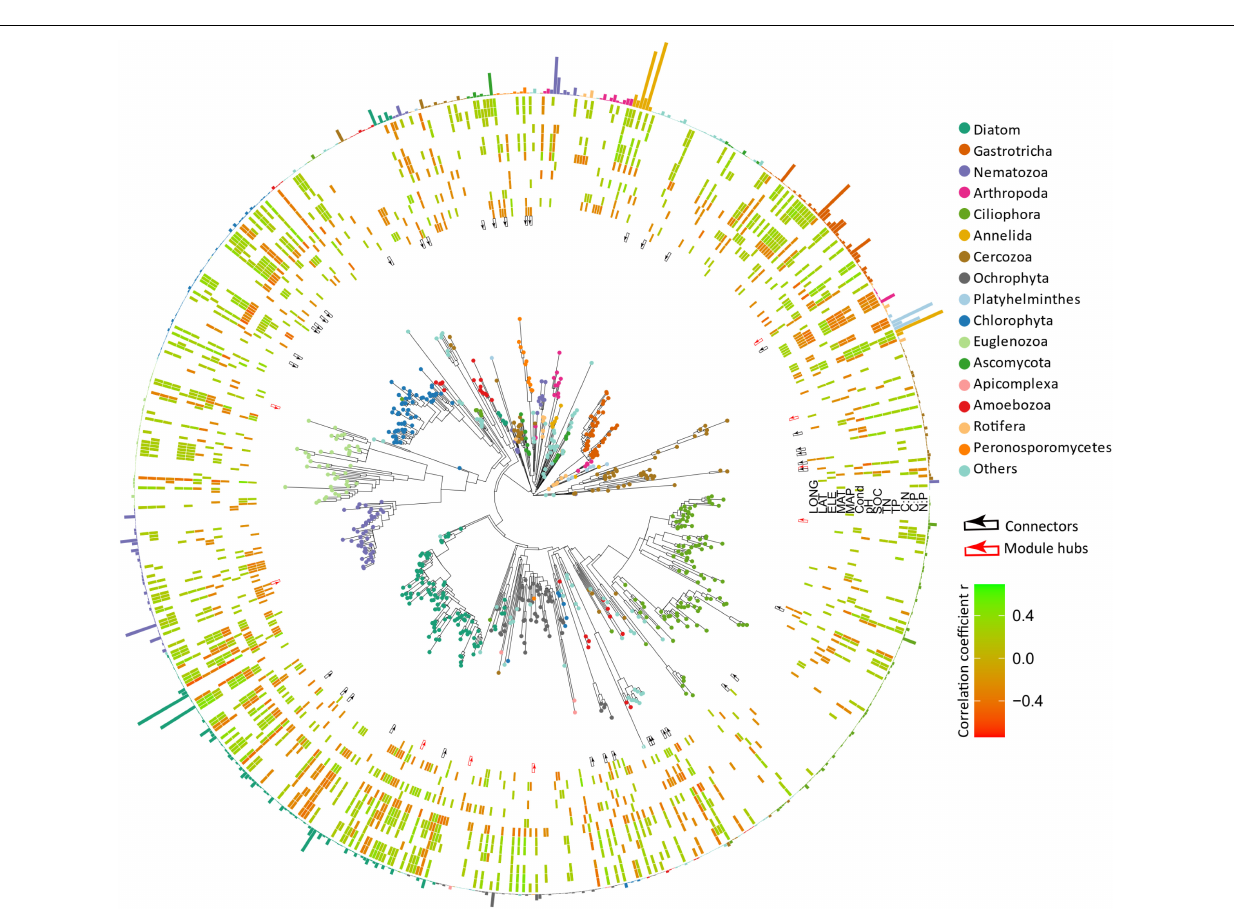
Frontiers in Ecology and Evolution |